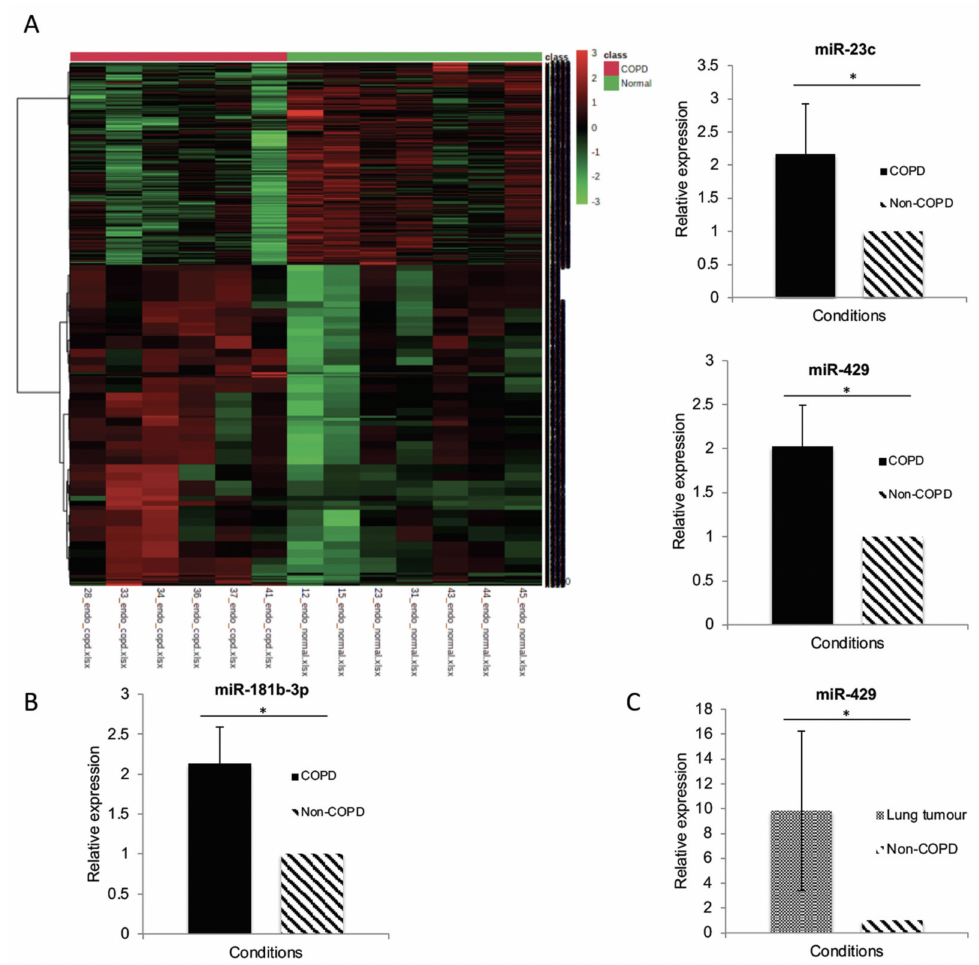
Figure 2. miR expression analyses. ( A ) Heatmap showing differentially expressed miR between COPD and non-COPD: this map comes from the final miR microarray analysis and is limited to the top 1000 miR significantly different in the test array. ( B ) qPCR validation of miR in COPD vs. non-COPD: bar charts represent relative expression for a miR. RNU48 was used as the house-keeping small RNA to which the data were normalised. The double delta CT method was used to compare expression levels; the 3 miR shown were significant at p <0.05. ( n = 4 both groups). ( C ) qPCR validation of miR in cancer vs. non-cancer tissue: miR-429 was the only miR that was also significantly altered in tumour ( n = 6) vs. normal lung ( n = 4) ( p = 0.017); relative expression was also higher than COPD lung. * = p <